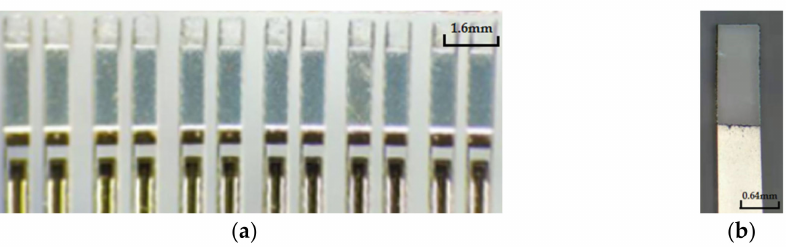
Figure 14. Results of frequency modulation processing under optimized parameters (the black edge of the silver layer oxidation is less): ( a ) 20 × microscope observation; ( b ) 50 × microscope observation. 30720 MCRs in 480 rows, namely, 30 slices of wafers, are processed in the verification experiments. The average frequency modulation processing time of a single-row MCR is depicted in Figure 15. The average processing completion time is 293.79 s, which is lower than the target time of 320 s, reaching the requirements for production efficiency.